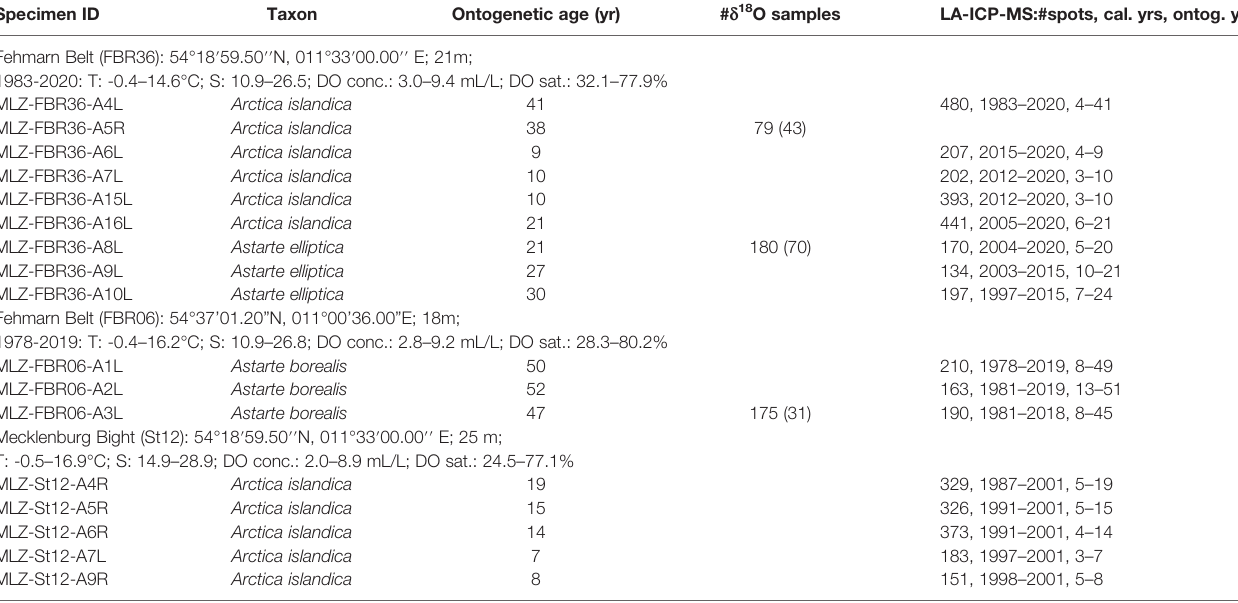
TABLE 1 | List of bivalves from the Baltic Sea used in the present study along with basic environmental data (monthly temperature, T, salinity, S, dissolved oxygen concentration, DO conc., and DO saturation, DO sat). Specimen